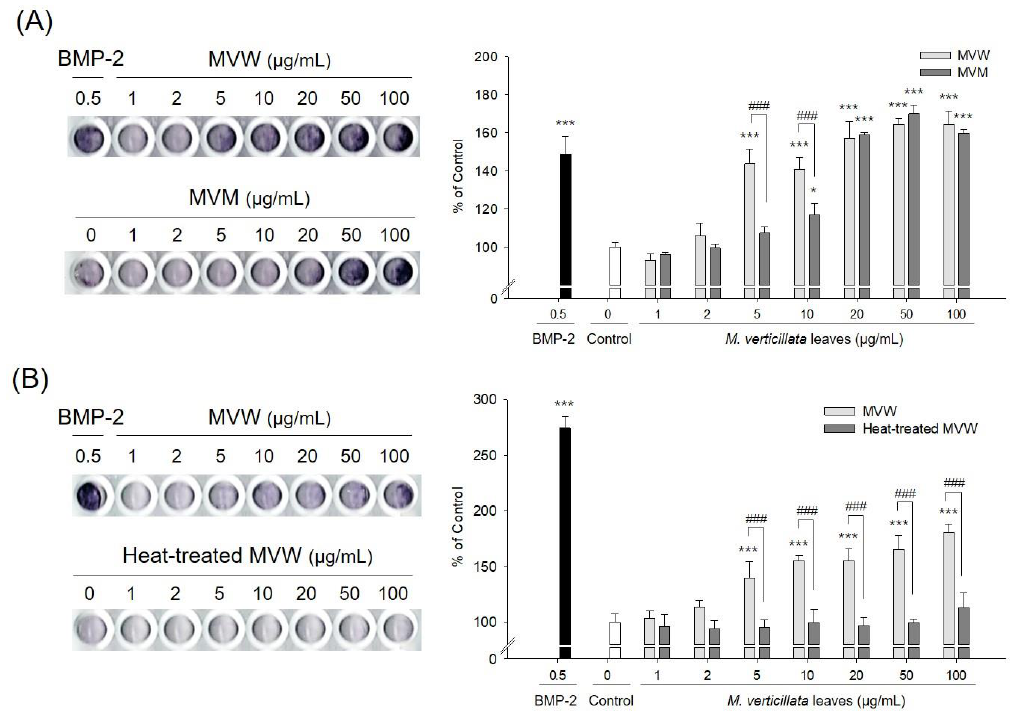
Figure 1. E ff ect of the extraction solvents ( A ) and heat treatments ( B ) on osteoblast di ff erentiation of M. verticillata leaves. MVW: aqueous extracts of M. verticillata leaves; MVM: methanol extracts of M. verticillata leaves; BMP-2: bone morphogenetic protein-2. Significant di ff erences were observed when compared with the controls: * p < 0.05, *** p < 0.001; significant di ff erences were also observed between the two groups: ### p < 0.001 .